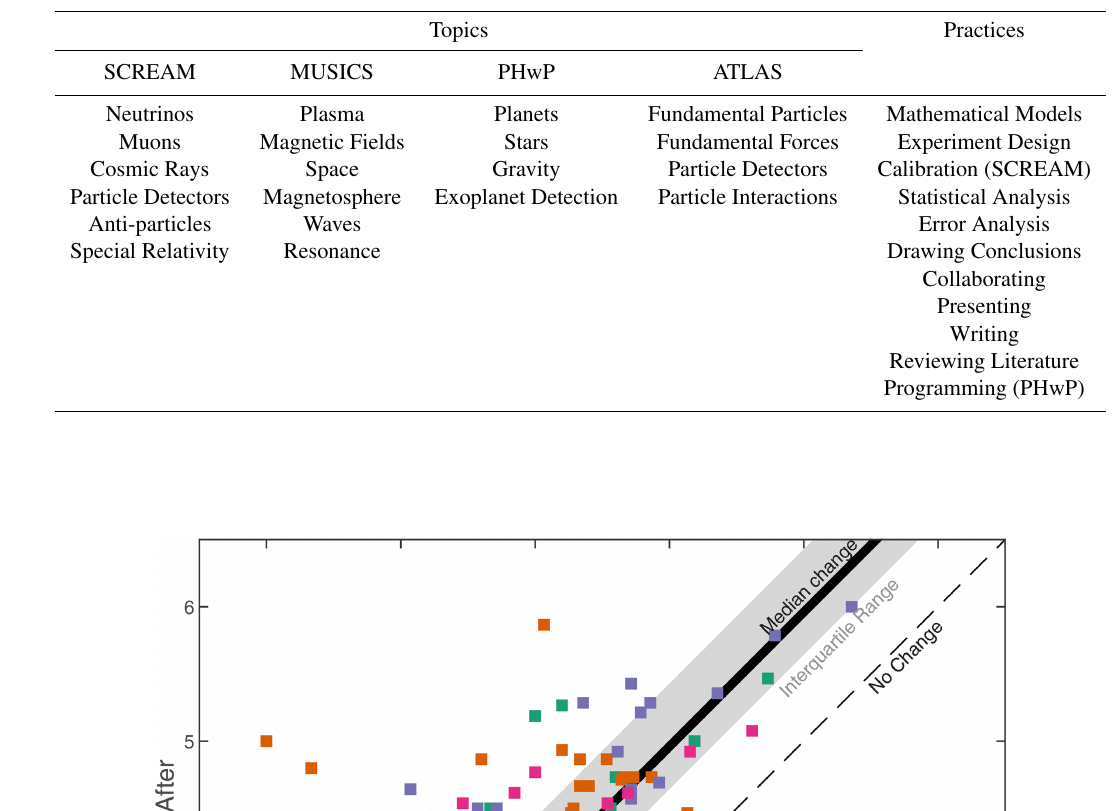
Table 3. The scientific topics and practices used in assessing students’ confidence.